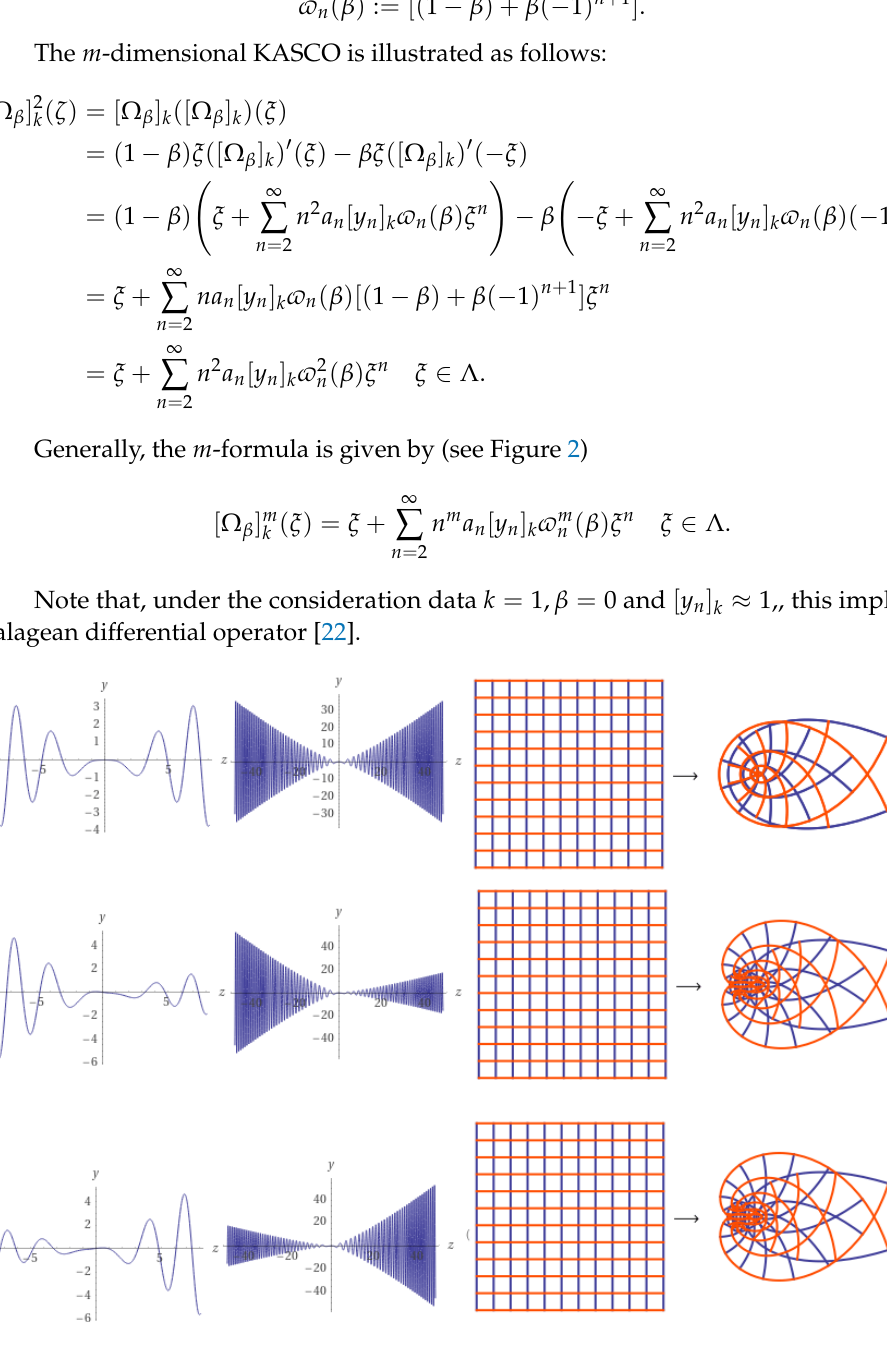
Figure 2. The graph of KASCO, when m = k = 1, β = 1/2,1/4,3/4